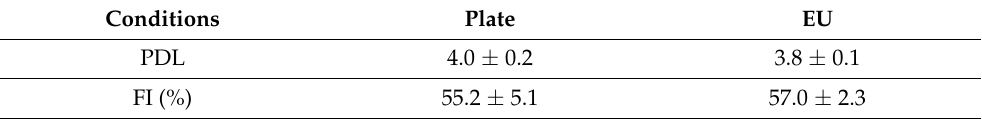
Table 3. Population doubling level (PDL) and fusion index (FI). The proliferation rate was calcu- lated as the PDL after 10 days of culture. The ability to fuse was calculated as FI (%) after 7 days of differentiation.